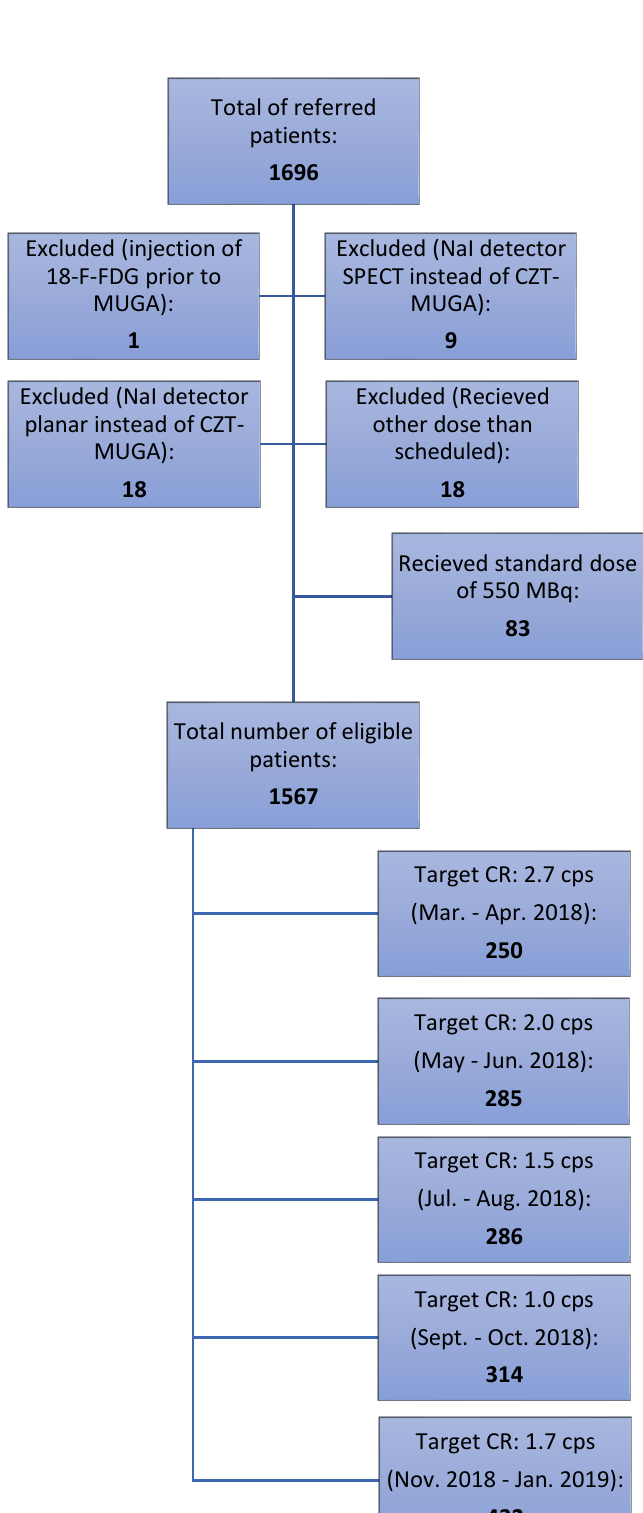
Figure 1. Flow chart of patients in and excluded from the study.